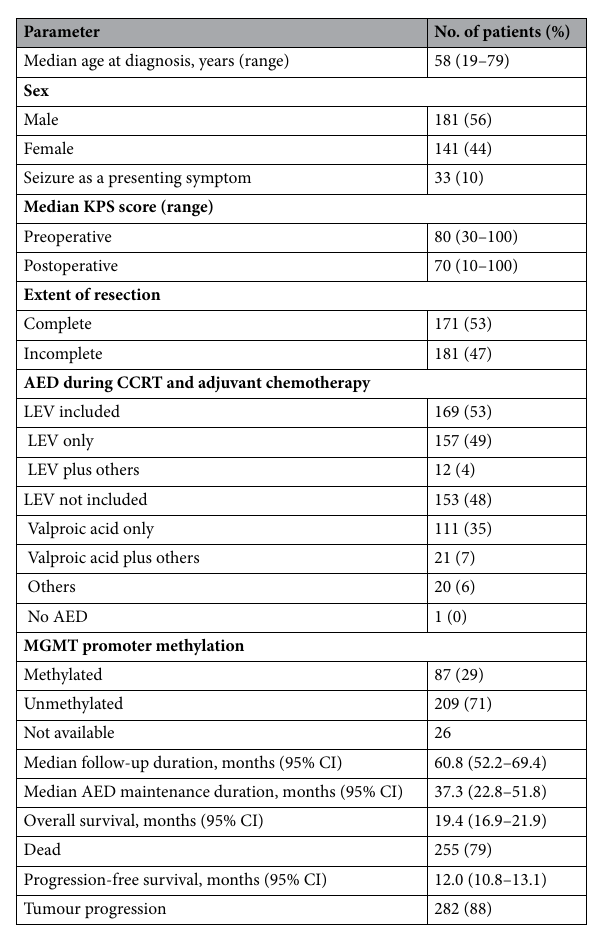
Table 1. Patient demographics (N = 322). KPS Karnofsky Performance Status, AED antiepileptic drug, CCRT concurrent chemoradiotherapy, LEV levetiracetam, MGMT O 6 -methylguanine-DNA methyltransferase, CI confidence interval.